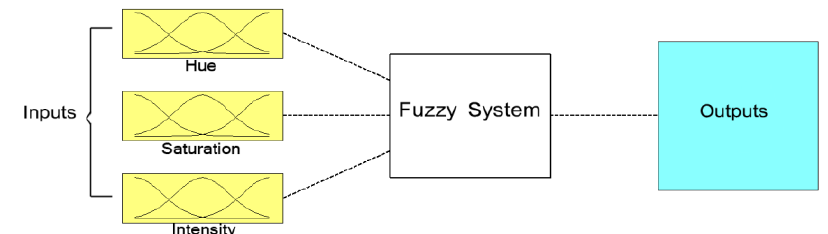
Figure 1. Fuzzy color pixel classification